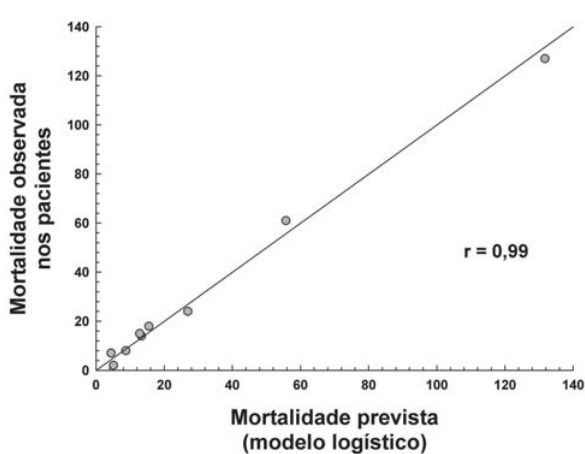
Fig. 2 - Dispersão de pontos representando as mortalidades previstas (pelo modelo logístico) e observada entre os pacientes (n=2089; eventos = 280 óbitos) O coeficiente Pearson foi de r=0,99 e teste de Hosmer-Lemeshow = 0,617, indicando bom desempenho do